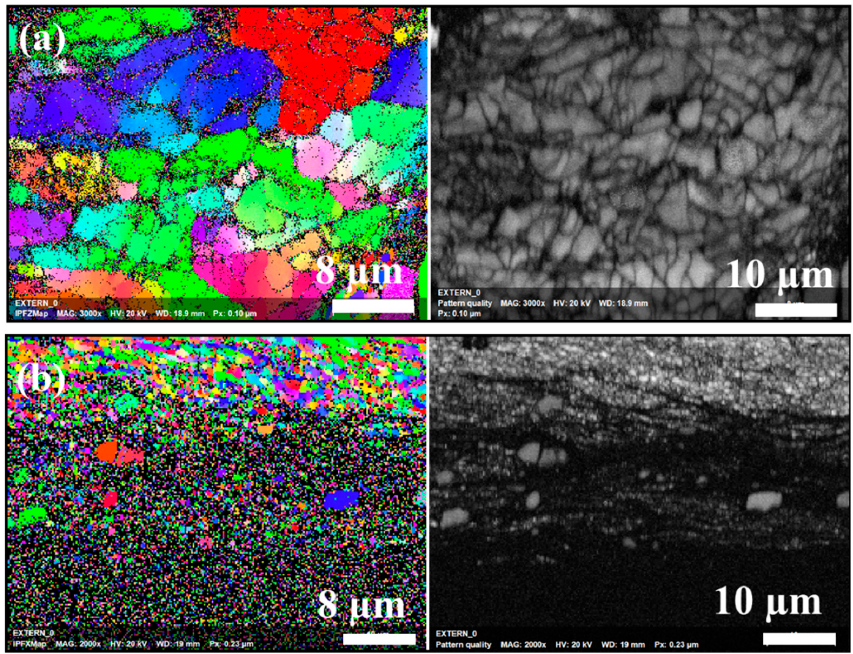
Figure 8. ( a ) S2 and ( b ) FSP ‐ S2 coatings’ Inverse pole figure (IPF) images and the corresponding gray ‐ scale images with large ‐ angle grain